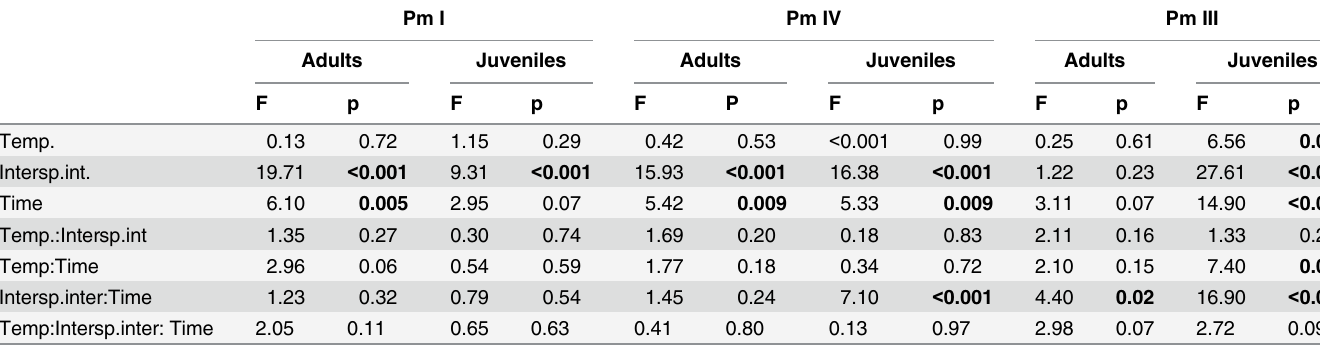
Table 1. Statistical results of the effect of temperature regime on fitness.